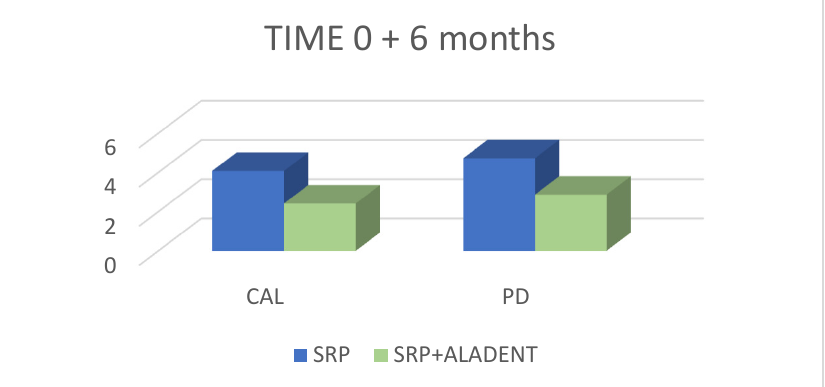
Figure 5. CAL and PD mean values (mm) of the selected sites after treatment with SRP alone and SRP plus